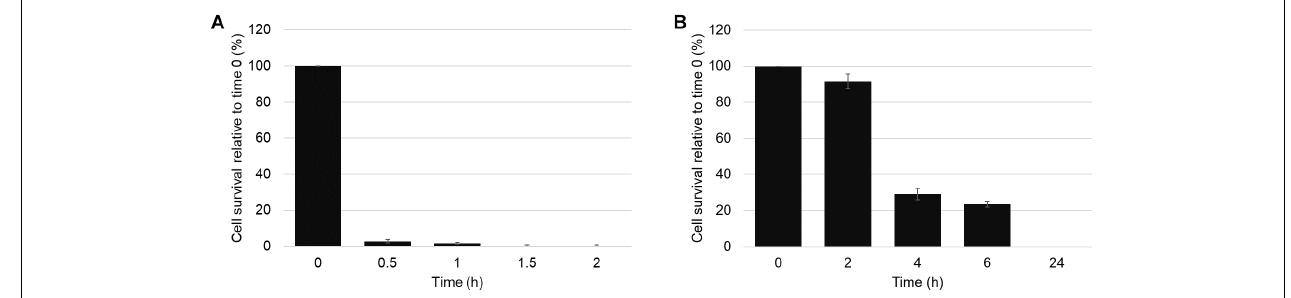
FIGURE 2 | Cell killing by ZmD32 is slowed in media containing 100 mM NaCl. (A) CFU cell viability of C. albicans cells (OD 600 of 0.1) after treatment with ZmD32 (10 µ M) in 1 / 2 PDB. Cell viability decreased by more than 95% after 30 min of treatment and no viable cells were present after 90 min. (B) CFU cell viability assays with ZmD32 (10 µ M) in 1 / 2 PDB supplemented with 100 mM NaCl. About 9% of the cells died after a 2 h incubation compared to 69% after 4 h, 76% at 6 h, and 100% at 24 h. The error bars represent the standard deviation of two independent experiments.